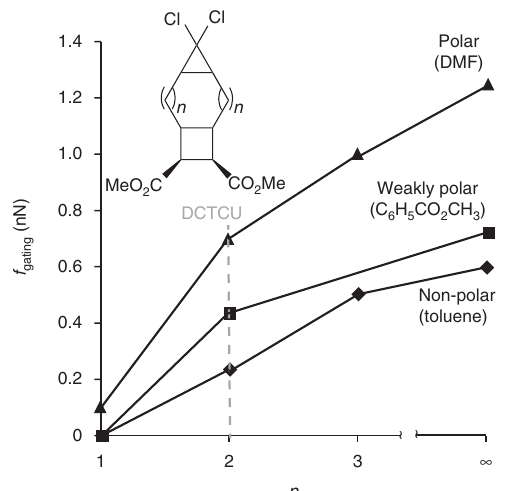
Figure 6 | Gating as a function of intervening ring size. The calculated f gating (see text for assumptions and computational details) depends on solvent polarity and the size of the separating ring, n . Data for n ¼ N corresponds to a central ring large enough to impose no compressive strain in corresponding TS1 (green structure, Fig. 1a) and was extrapolated using force-dependent activation free energy of ring opening of cis -1,1-dichloro-